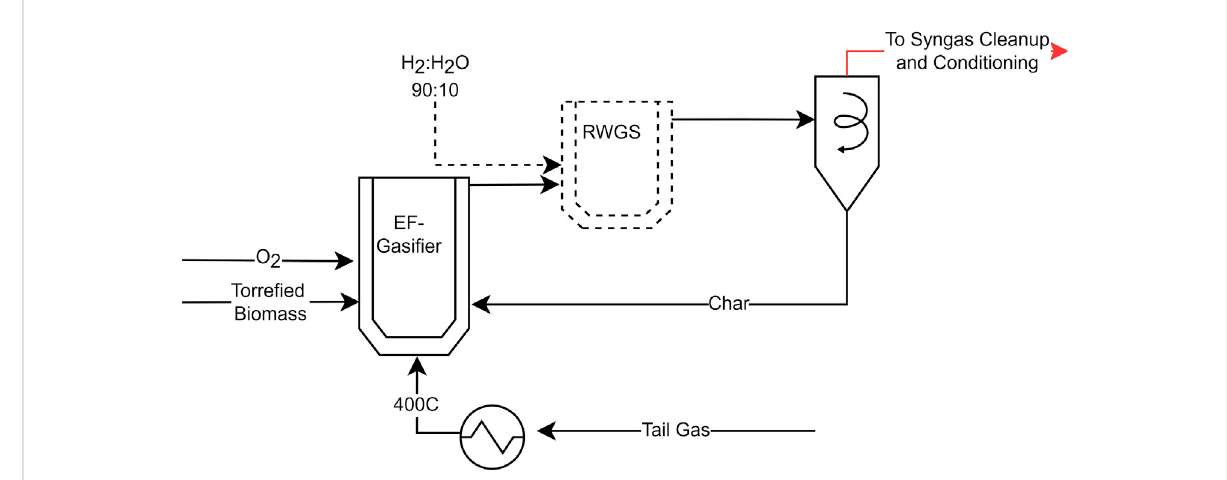
FIGURE 3 Block diagram of the biomass gasi fi cation process.